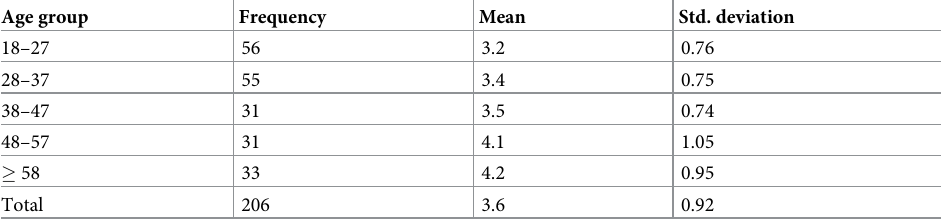
Table 5. Mean and standard deviation of common bile duct diameter by age group.